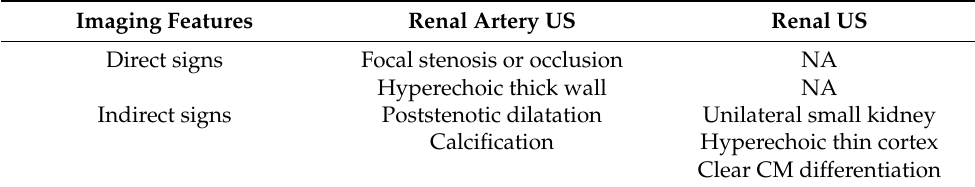
Table 3. Imaging features of renal artery stenosis on gray-scale US.